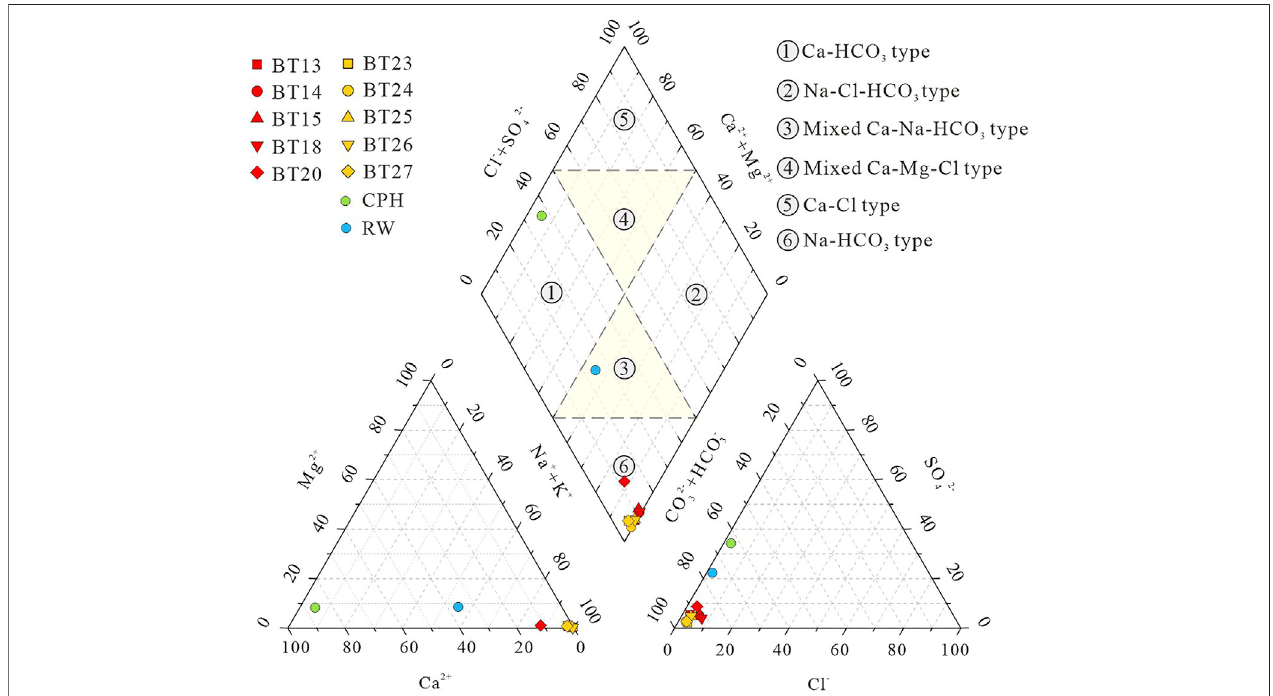
FIGURE 4 | Piper plot of water samples (modi fi ed from Piper, 1994; Zhang Y. et al., 2018).